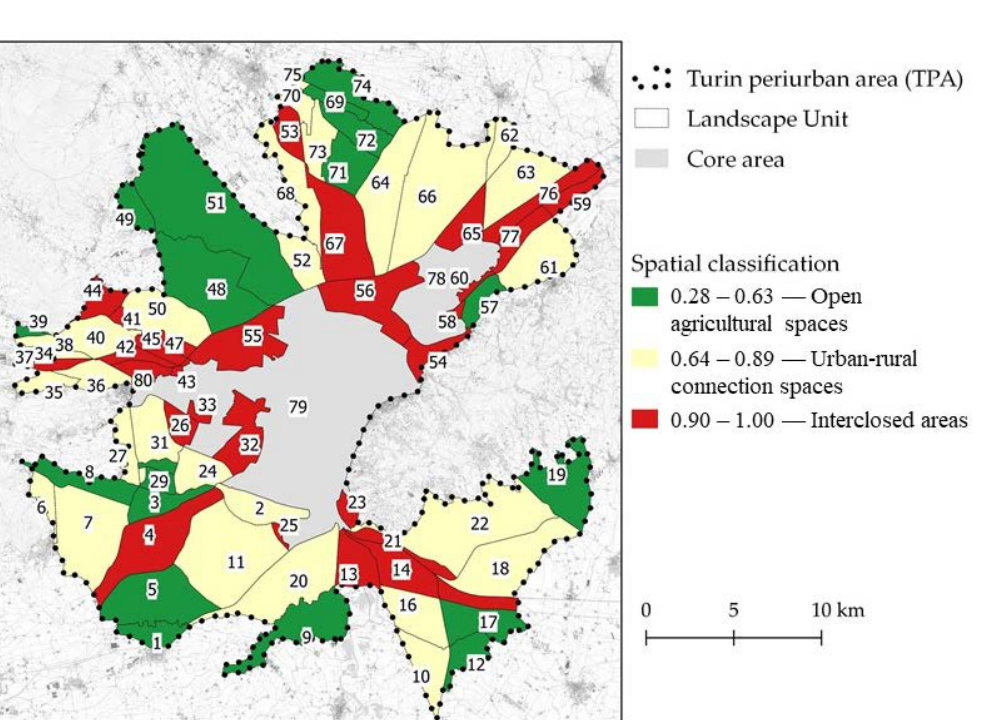
Figure 4. Map of the peri-urban landscape units.